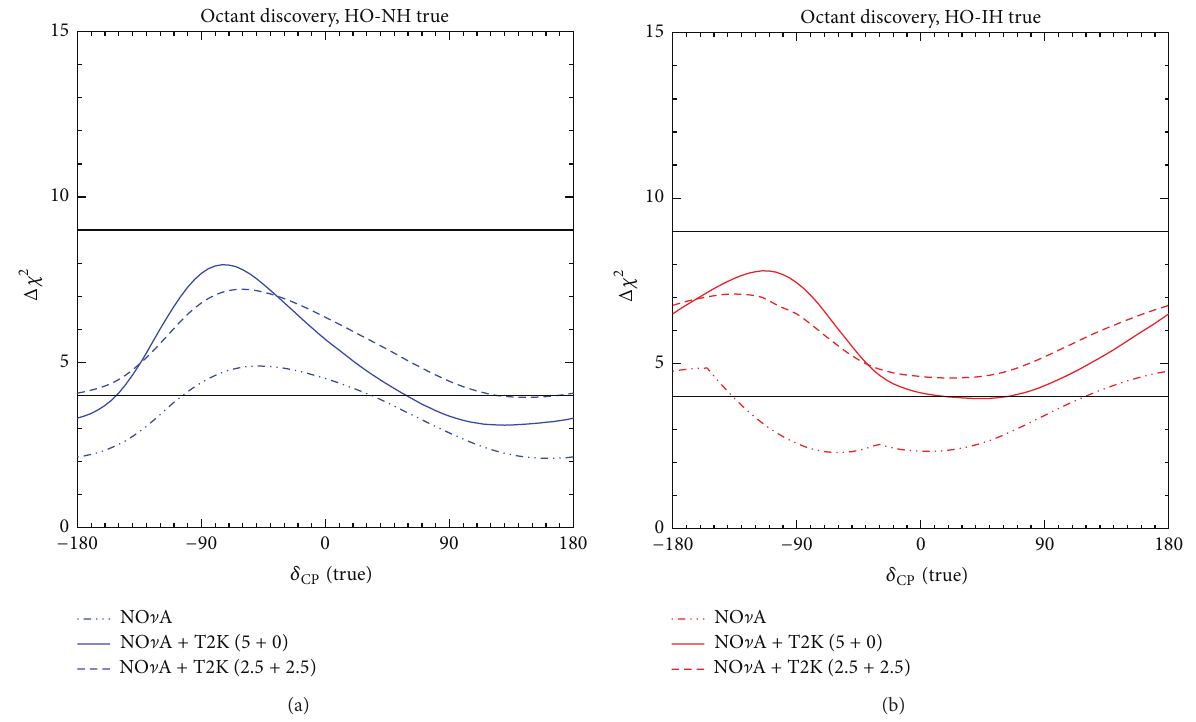
Figure 10: Octant resolving capability as a function of true 𝛿 left (right) panel corresponds to NH (IH) being the true hierarchy. This figure has been taken from